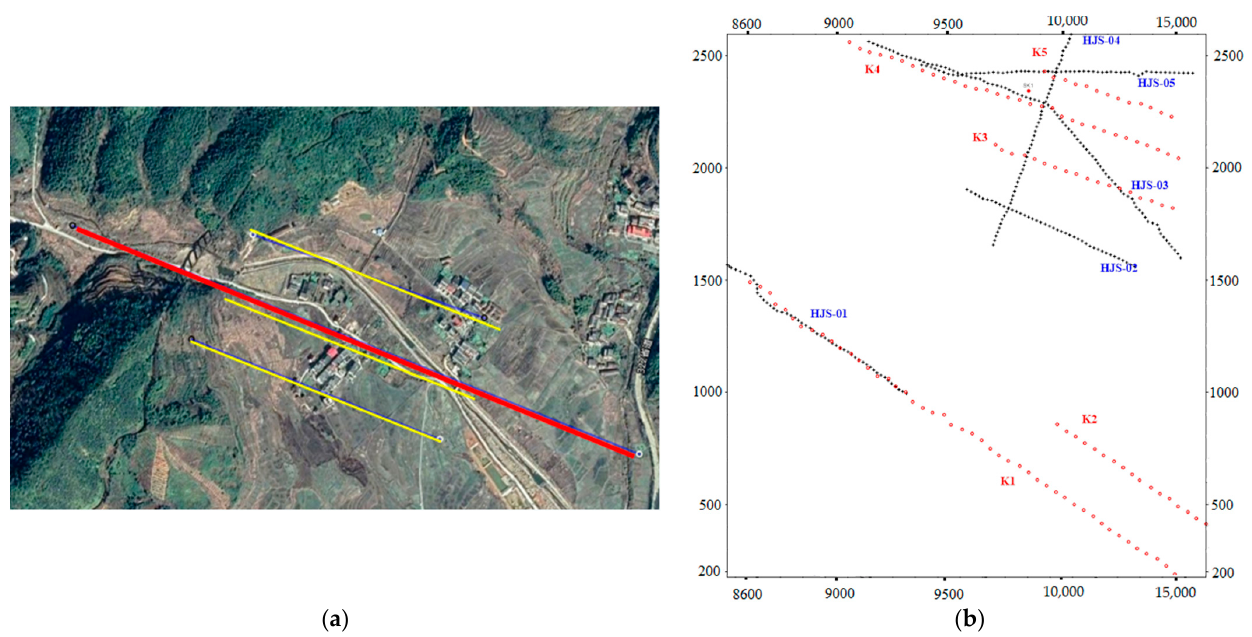
Figure 6. Geophysical prospecting arrays in Hejiashan survey area. ( a ) Pseudo-3D arrays. ( b ) The combined profiling method, resistivity sounding method, and CSAMT arrays (the black cross-shaped measuring points are the combined profiling and resistivity sounding points, and the red circles are the CSAMT measuring points).